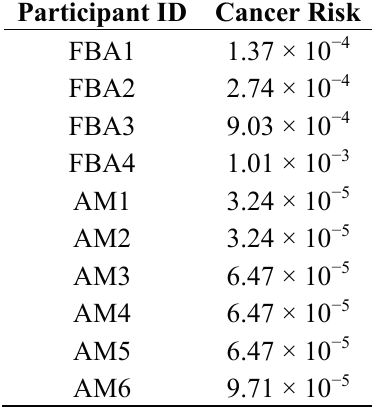
Table 4. Lifetime potential cancer risk for individual participants from exposure to benzene. The potential risk of 1 × 10 − 5 = 1 in 100,000; 1 × 10 − 4 = 1 in 10,000; and 1 × 10 − 3 = 1 in 1000 is based on the probability of developing cancer in a population